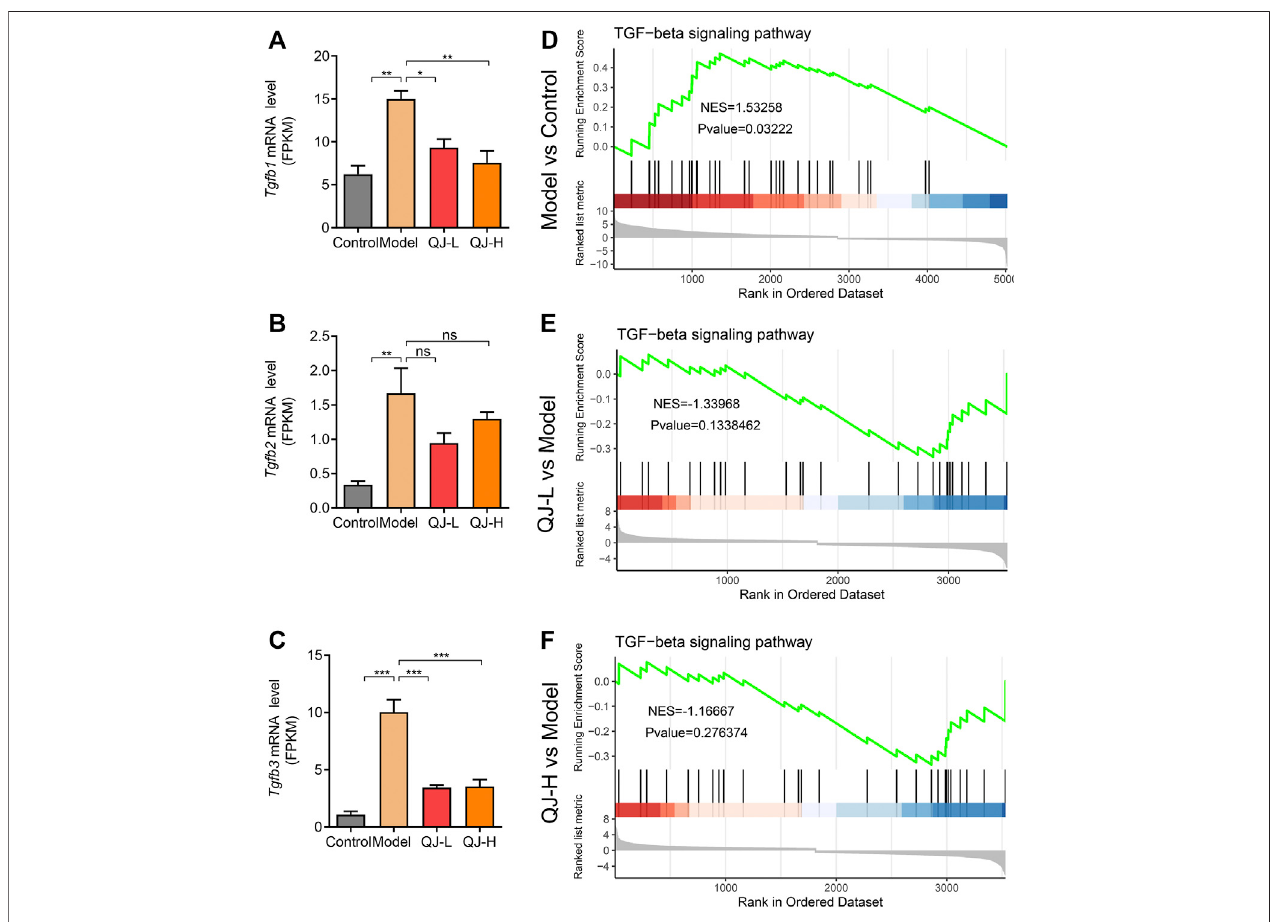
FIGURE 7 | Expression level and Gene Set Enrichment Analysis (GSEA) analysis of TGF-beta signaling. (A – C) Bulk RNA-seq analysis of the expression level of Tgfb1 , Tgfb2 , and Tgfb3 ( n = 3); (D – F) Gene Set Enrichment Analysis (GSEA) analysis of TGF-beta signaling. NES, normalized enrichment score; positive and negative NESs indicate higher and lower expression, respectively. * p < 0.05, ** p < 0.01, and *** p < 0.001. ns, not signi fi